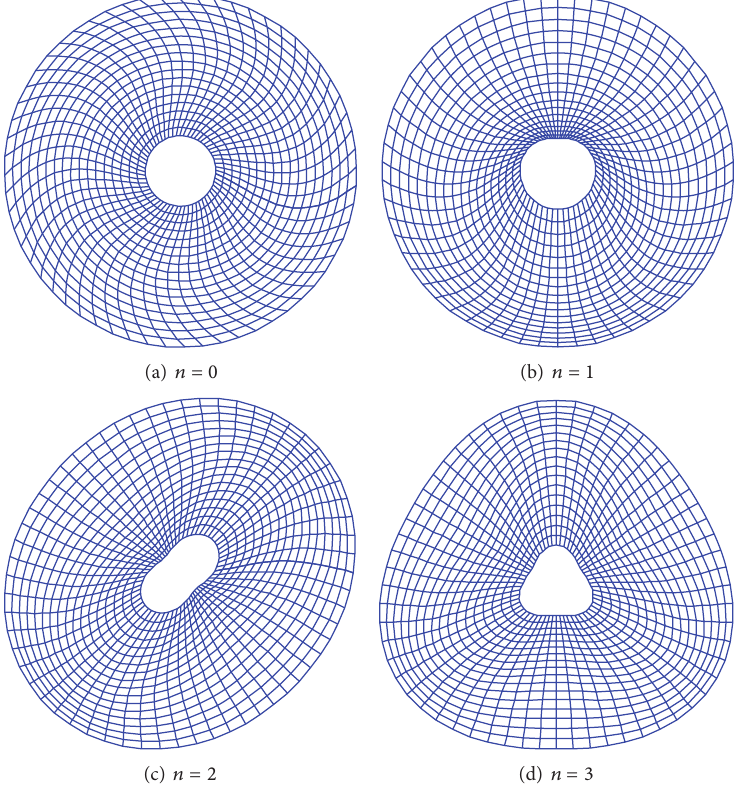
Figure 3: Mode shapes for elastic restrained annular plate (𝑎/𝑏 = 0.2) with 𝑛 = 0 , 1, 2, and 3.